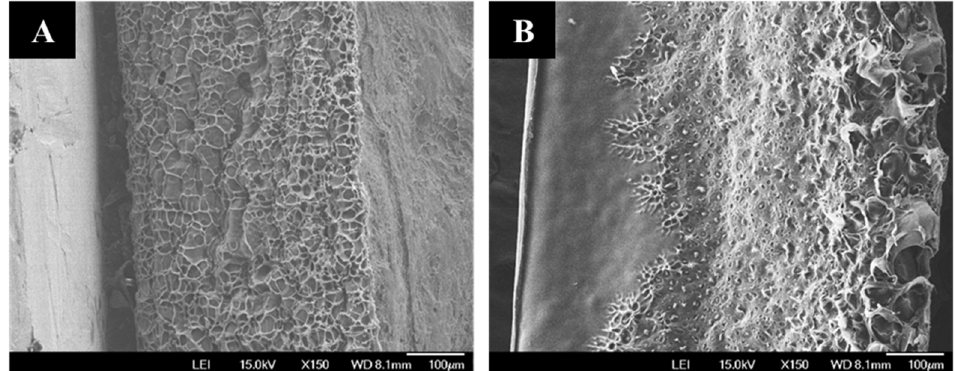
Figure 5. Cross-sectional SEM images of the freeze-dried hydrogels of ( A ) CMC–HEC SN and Figure 5. Cross ‐ sectional SEM images of the freeze ‐ dried hydrogels of ( A ) CMC–HEC SN and ( B ) ( B ) κ -CG/CMC–HEC DN κ‐ CG/CMC–HEC DN (1/25).